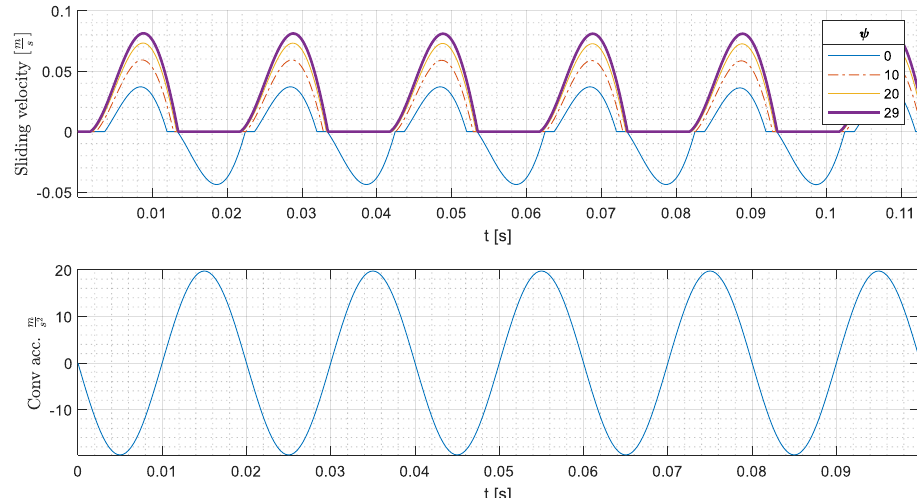
Figure 7. Numerical results, sliding velocity of the cylindrical part along the track, t < 0.1 s, θ = 3 ◦ , f v = 0.005, µ c = 0.3, µ s = 0.6, and parametric values of ψ .